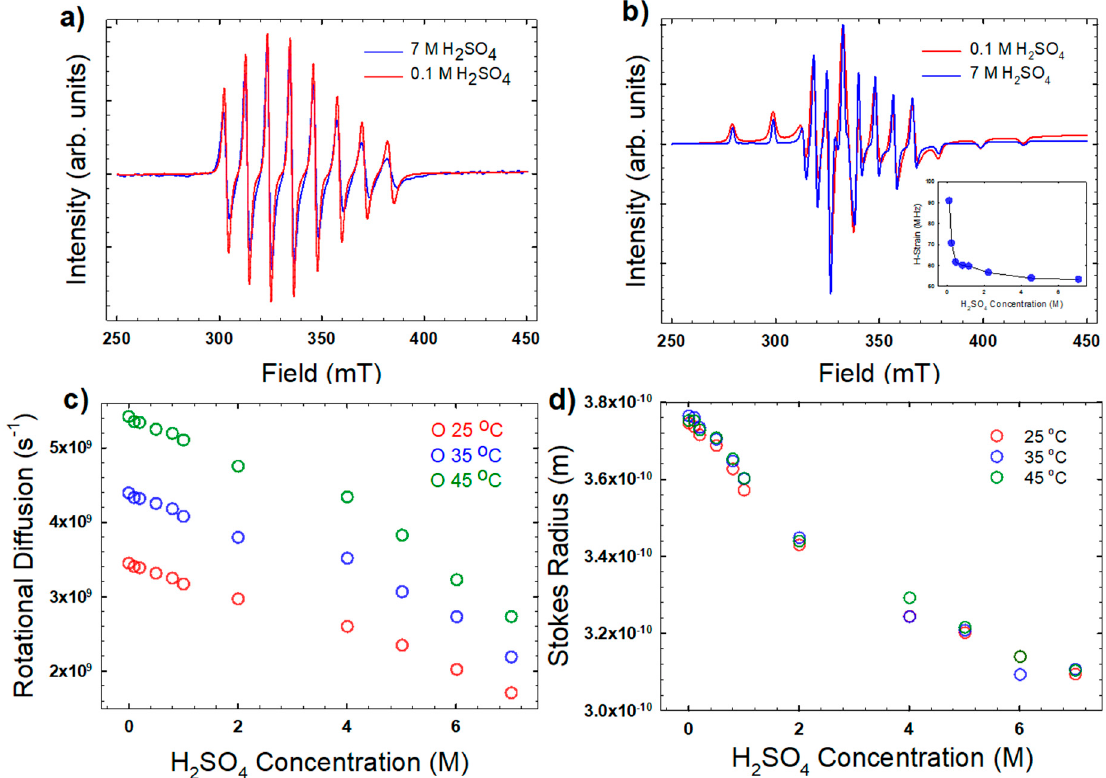
Figure 2. ( a ) Representative electron paramagnetic resonance (EPR) spectra at 25 °C for the highest and lowest H 2 SO 4 concentrations investigated; ( b ) EPR spectra collected at − 180 °C (inset shows unrefined hyperfine coupling); ( c ) extracted rotational diffusion coefficients using Equation (2); and ( d ) the Stokes radius of the vanadyl ion using Equation (2). EPR fitting parameters were A (cid:107) = 542.6 MHz; A ⊥ = 203.3 MHz; g (cid:107) = 1.943; and g ⊥ = 1.989.